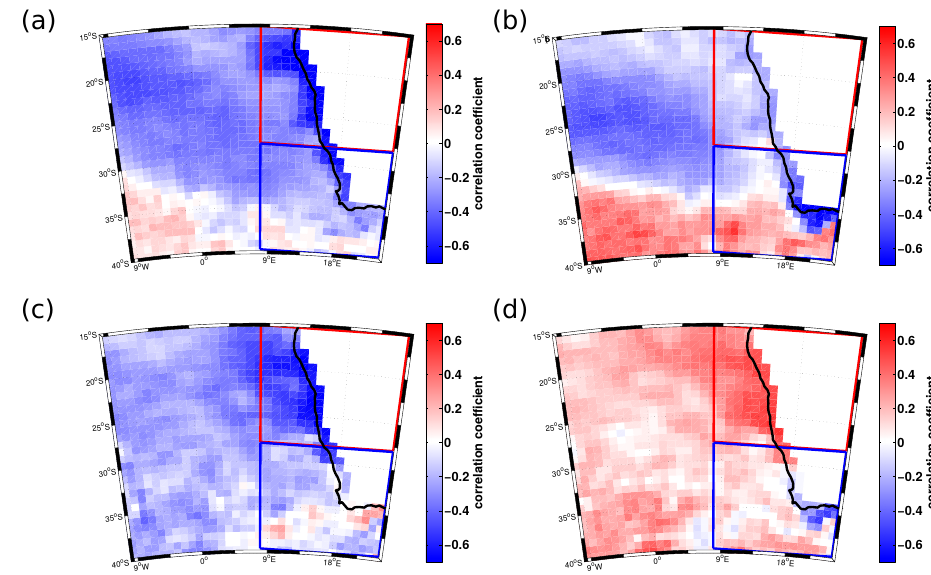
Figure 7. Correlation between upwelling indices derived from the vertical velocity and the sea surface temperature field of the STORM simulation (1950–2010) in austral summer (DJF) (North Benguela (a) , South Benguela (b) ), and in austral winter (JJA) (North Benguela (c) and South Benguela (d) ). Boxes indicate the regions used for the upwelling index of North Benguela (red) and South Benguela (blue).